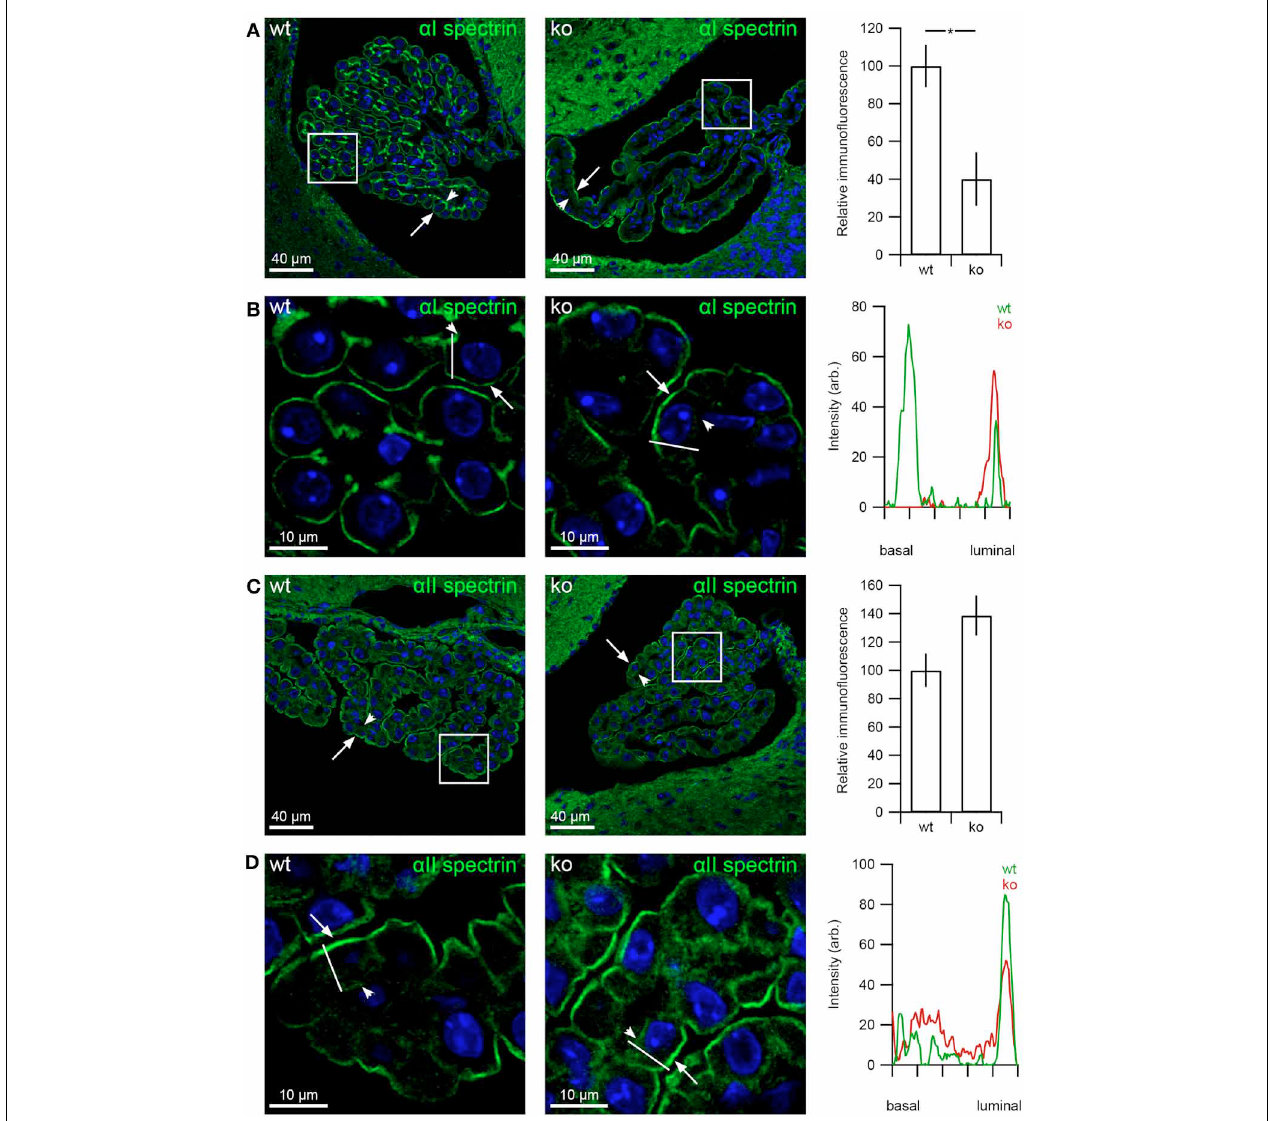
FIGURE 7 | Altered α 1-spectrin expression in CPE from slc4a10 ko mice. Mouse brain sections were immunostained for α I- and α II-spectrin. (A) Immunolabeling for α I-spectrin in slc4a10 wt and ko, as indicated. Bar graph on the right show the semi-quantitation of the respective immunofluorescence in slc4a10 wt and ko mouse CPE (wt: n = 5, ko: n = 4). (B) High magnification micrograph of the subcellular α I-spectrin staining pattern. The graph is a linescan of the cellular fluorescence signal from the basal to the luminal domain. The analyzed line is indicated on the micrographs. (C) Immunolabeling for α II-spectrin